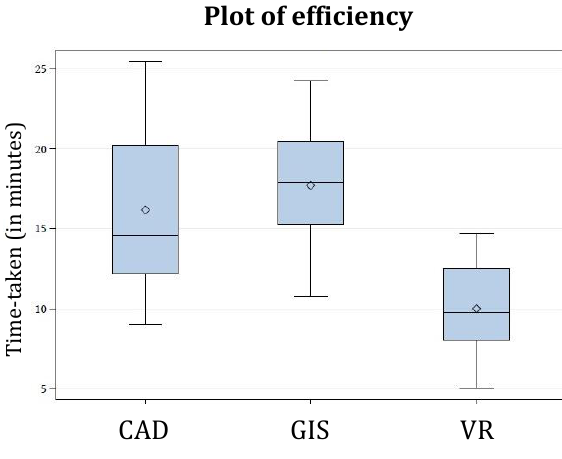
Figure 7. Time taken (in minutes) per environment (efficiency)